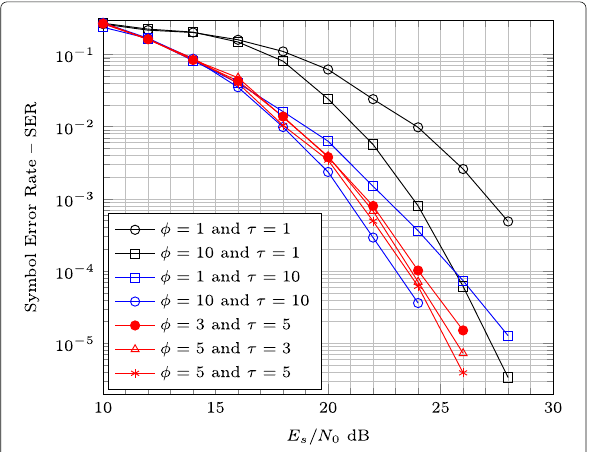
Fig. 9 SER performance for SCMA-GFDM with BEP equalizer and SPA multi-user detection for different values of φ and τ . This figure is better seen in colored